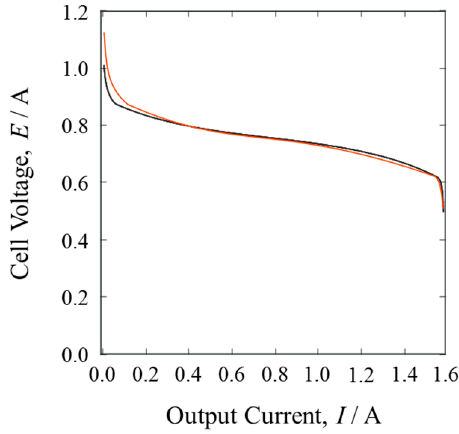
Figure 4. Cell current-voltage curves when PEFC was in operation with pure H 2 gas (black line) and mixture gases of H 2 and D 2 (red line).